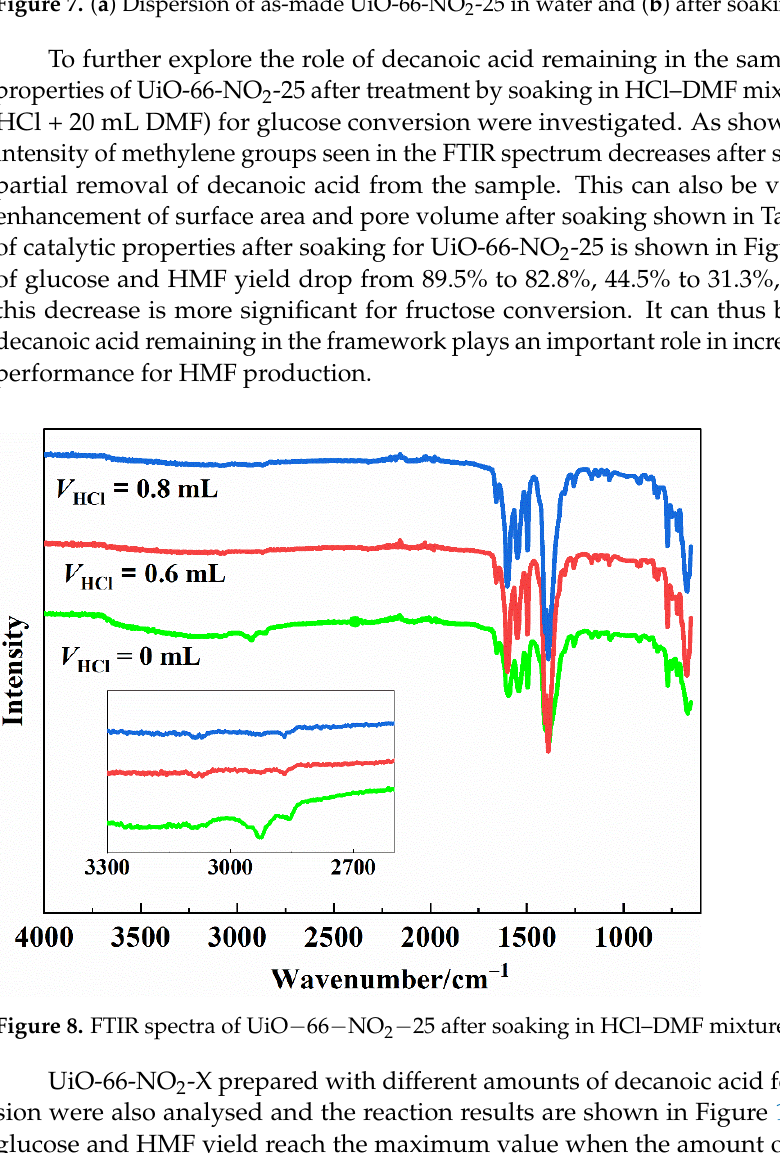
Figure 8. FTIR spectra of UiO − 66 − NO 2 − 25 after soaking in HCl–DMF mixture.